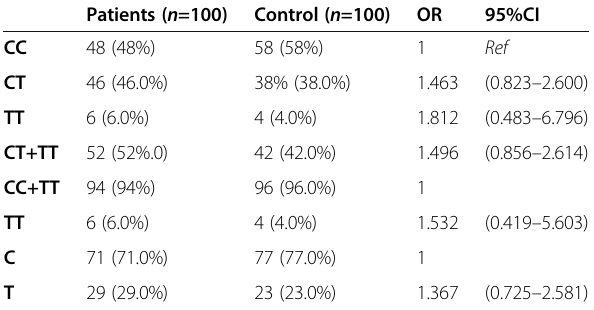
Table 4 Frequencies of MTHFR gene polymorphic genotypes and alleles among cases of RPL compared to